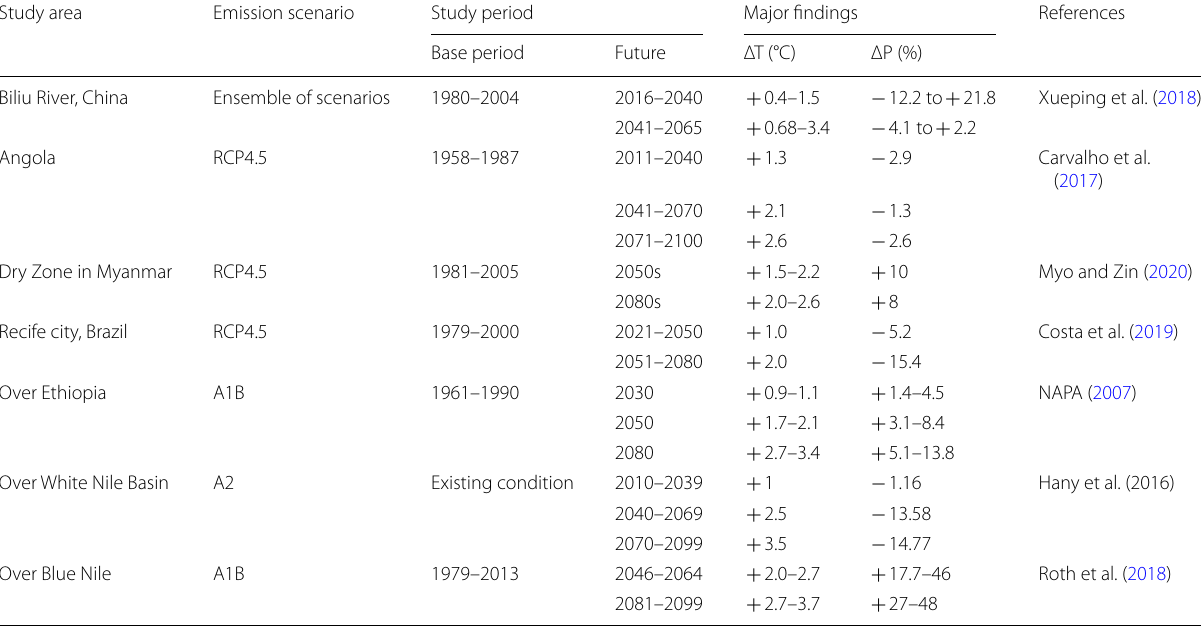
Table 1 Overview of previous studies on climate change scenarios Study